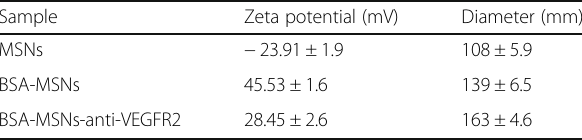
Table 1 Zeta potential and diameter of various particles Sample